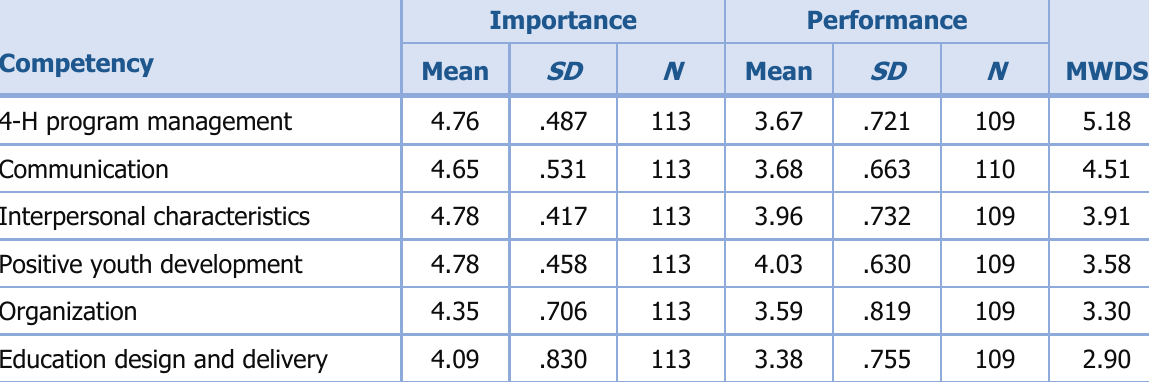
Table 3. 4- H Professionals’ Importance and Performance